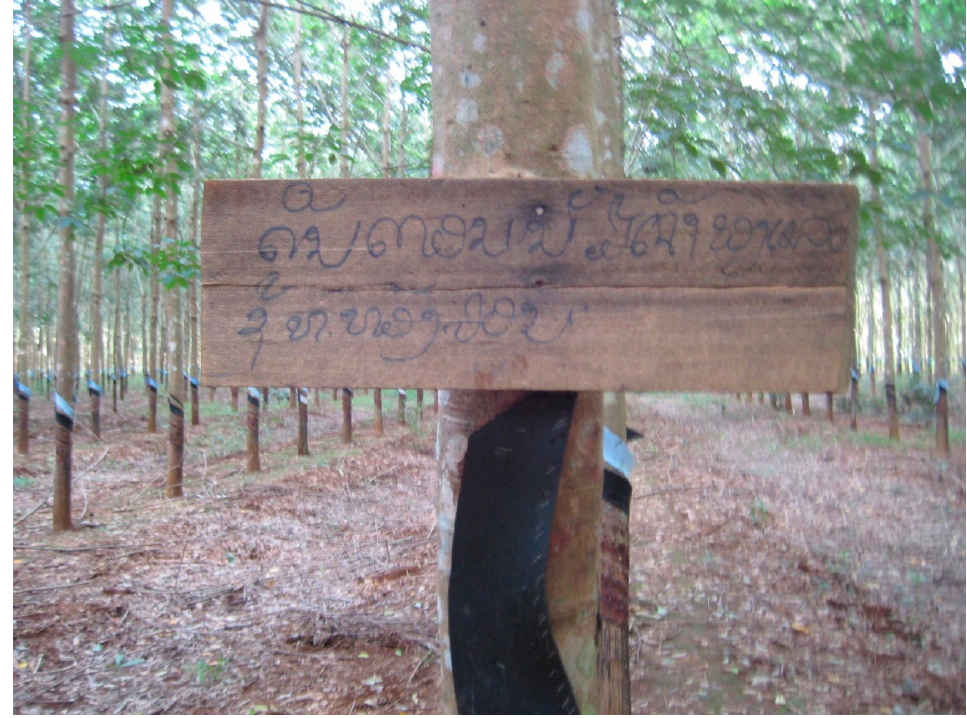
Figure 1. Photo of one of 55 signs in the villager-occupied rubber plantation near Yeup Village, Thateng District, Xekong Province, southern Laos.